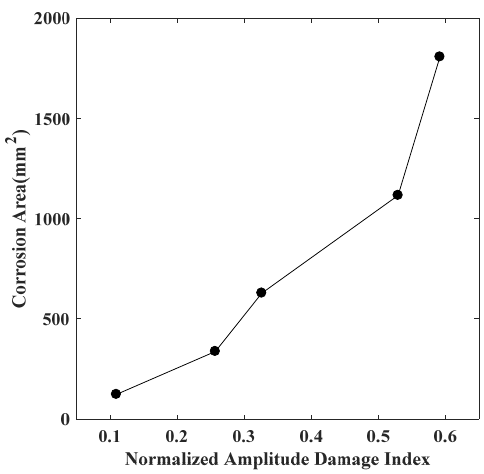
Figure 16. Normalized amplitude damage index versus corrosion area.